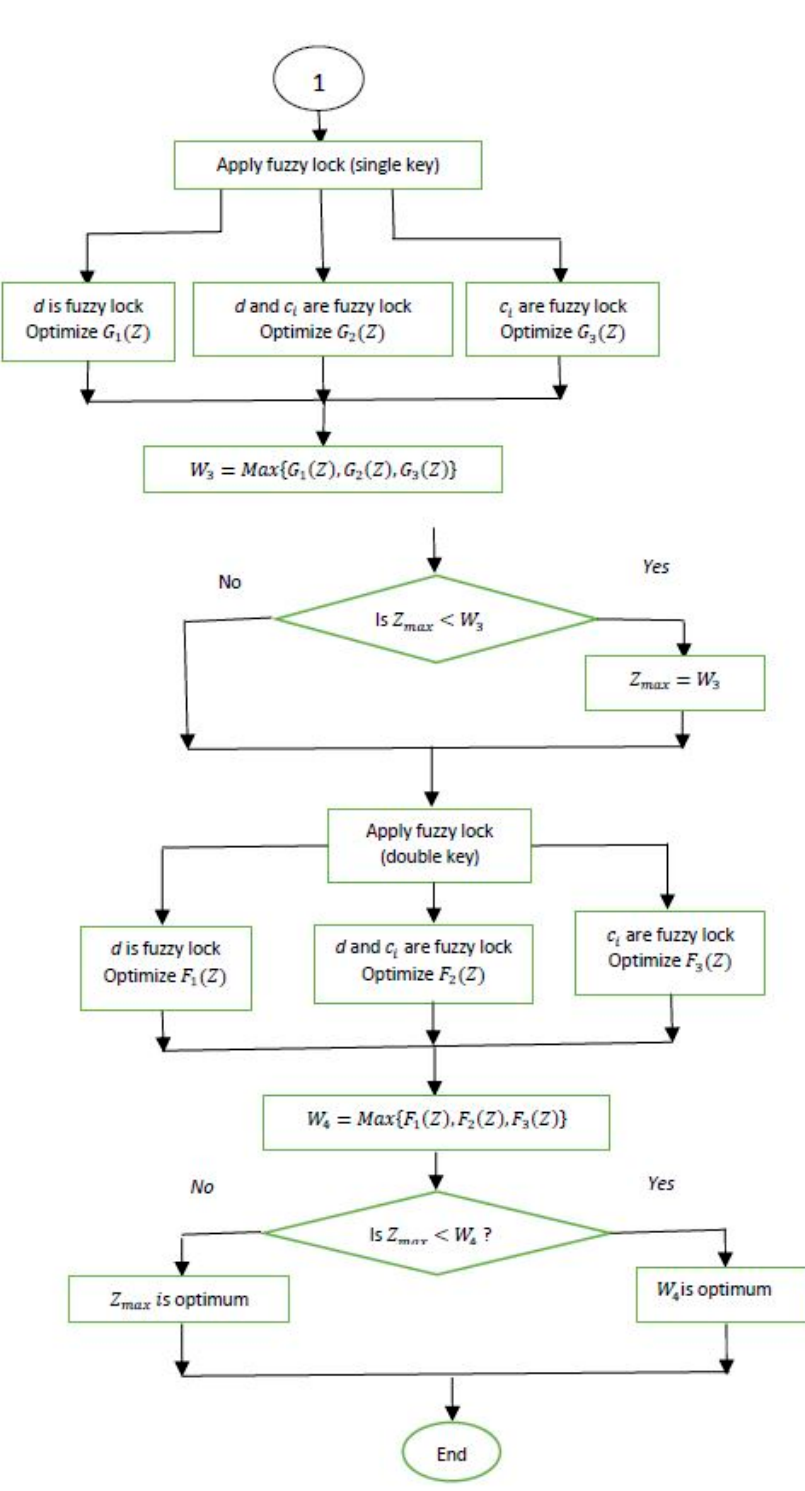
Figure 4. Flow chart of the proposed mode.